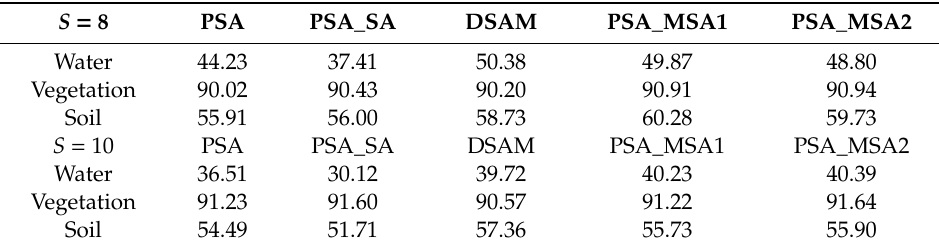
Table 8. Improved PCC (cid:48) values (%) of di ff erent land covers types for the five methods.